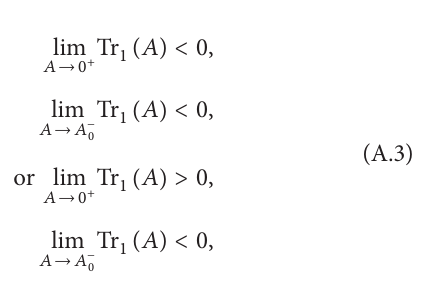
Figure 6: The time evolution of resource 𝑥 when 𝐴 = 0.1651 , 𝑚 = 0.3 , 𝑏 = 0.2 , 𝑑 = 0.8 , 𝑐 = 0.25 , 𝛽 = 2.4 , 𝛼 = 1.7 , ℎ = 1.2 , and 𝜔 = 0.6 , where the cases of blue solid and dash lines are corresponding to initial conditions (3.825, 0.356, 0.323) and (0.825, 0.356, 0.323) ,